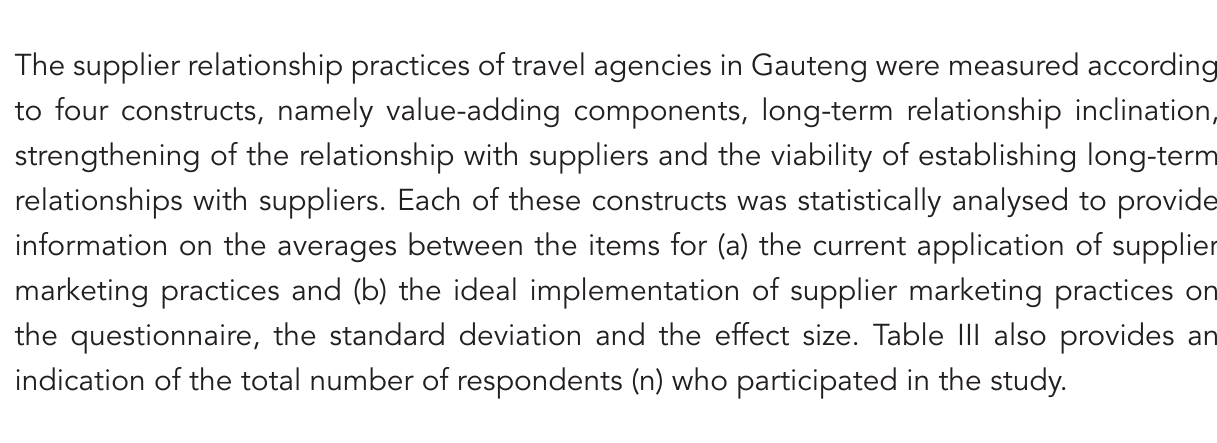
Table III: Constructs for supplier market